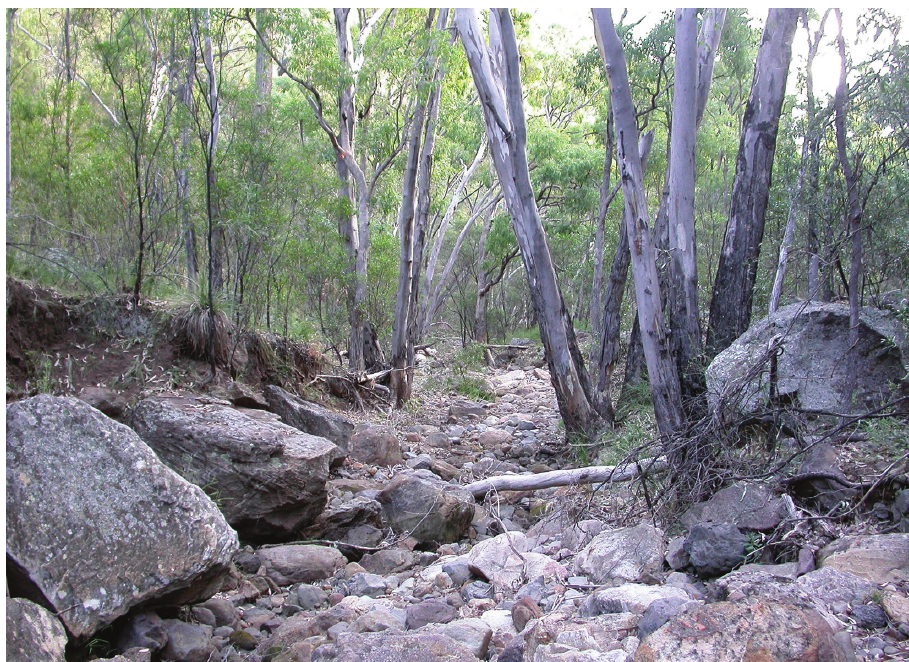
Figure 4. Warrumbungle National Park (New South Wales, Australia), creek bed in dry sclerophyll for- est. Habitat of Zelothrix warrumbungle sp. n. where large numbers of individuals may be present during the summer months (Photo credit: Shaun L.